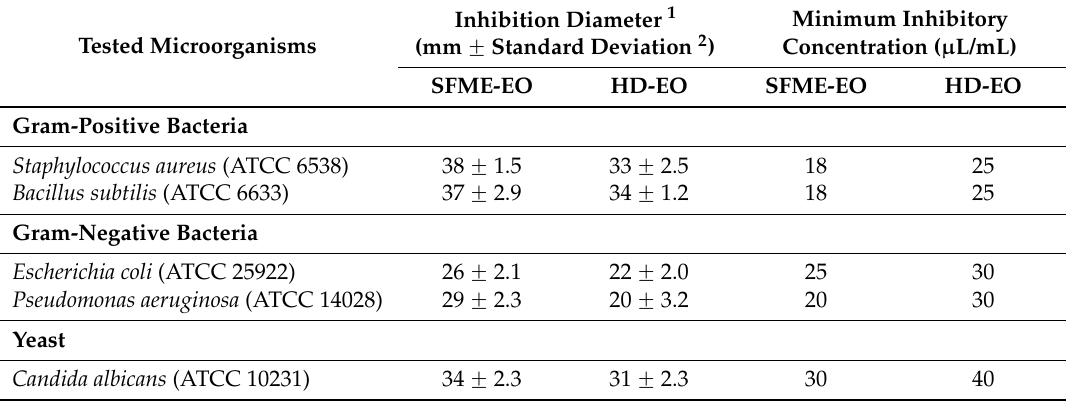
Table 4. Result of antimicrobial activity of sweet basil EO obtained by SFME and HD.